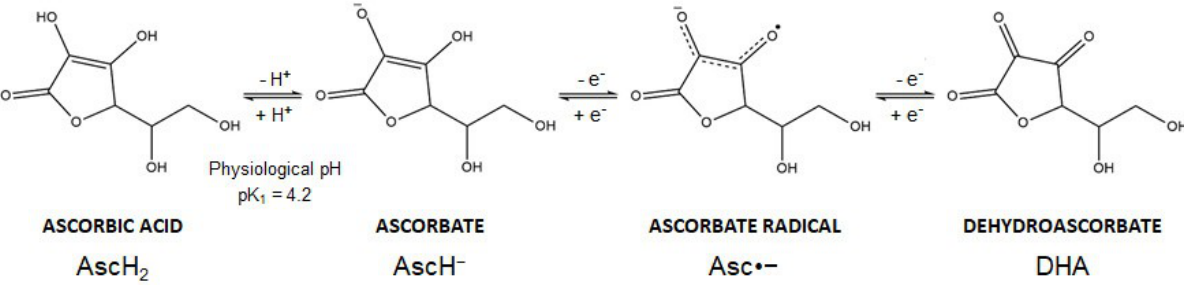
Figure 2. Vitamin C has different chemical structures. At physiological pH, ascorbic acid loses a proton to form ascorbate, which can donate two electrons sequentially. Loss of the first electron (oxidation) generates ascorbate radical and the loss of the second electron produces dehydroascorbate. See text for further details.